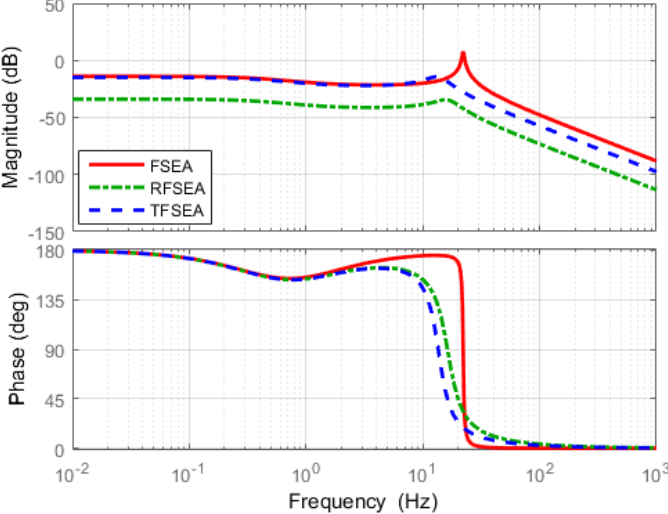
Figure 19. Frequency Response Functions (FRFs) of Force